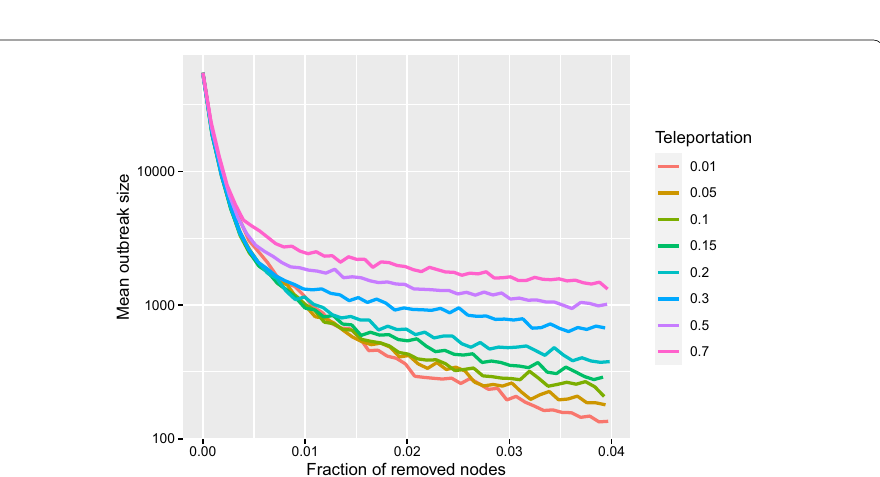
Fig. 7 Mean final outbreak size over 10,000 simulations for an infection on the 2015 complete BDNI network, with nodes removed according to out-TempoRank centrality computed on the 2014 complete BDNI network, with fixed laziness q = 0.1 and varying teleportation parameters d (logarithmic